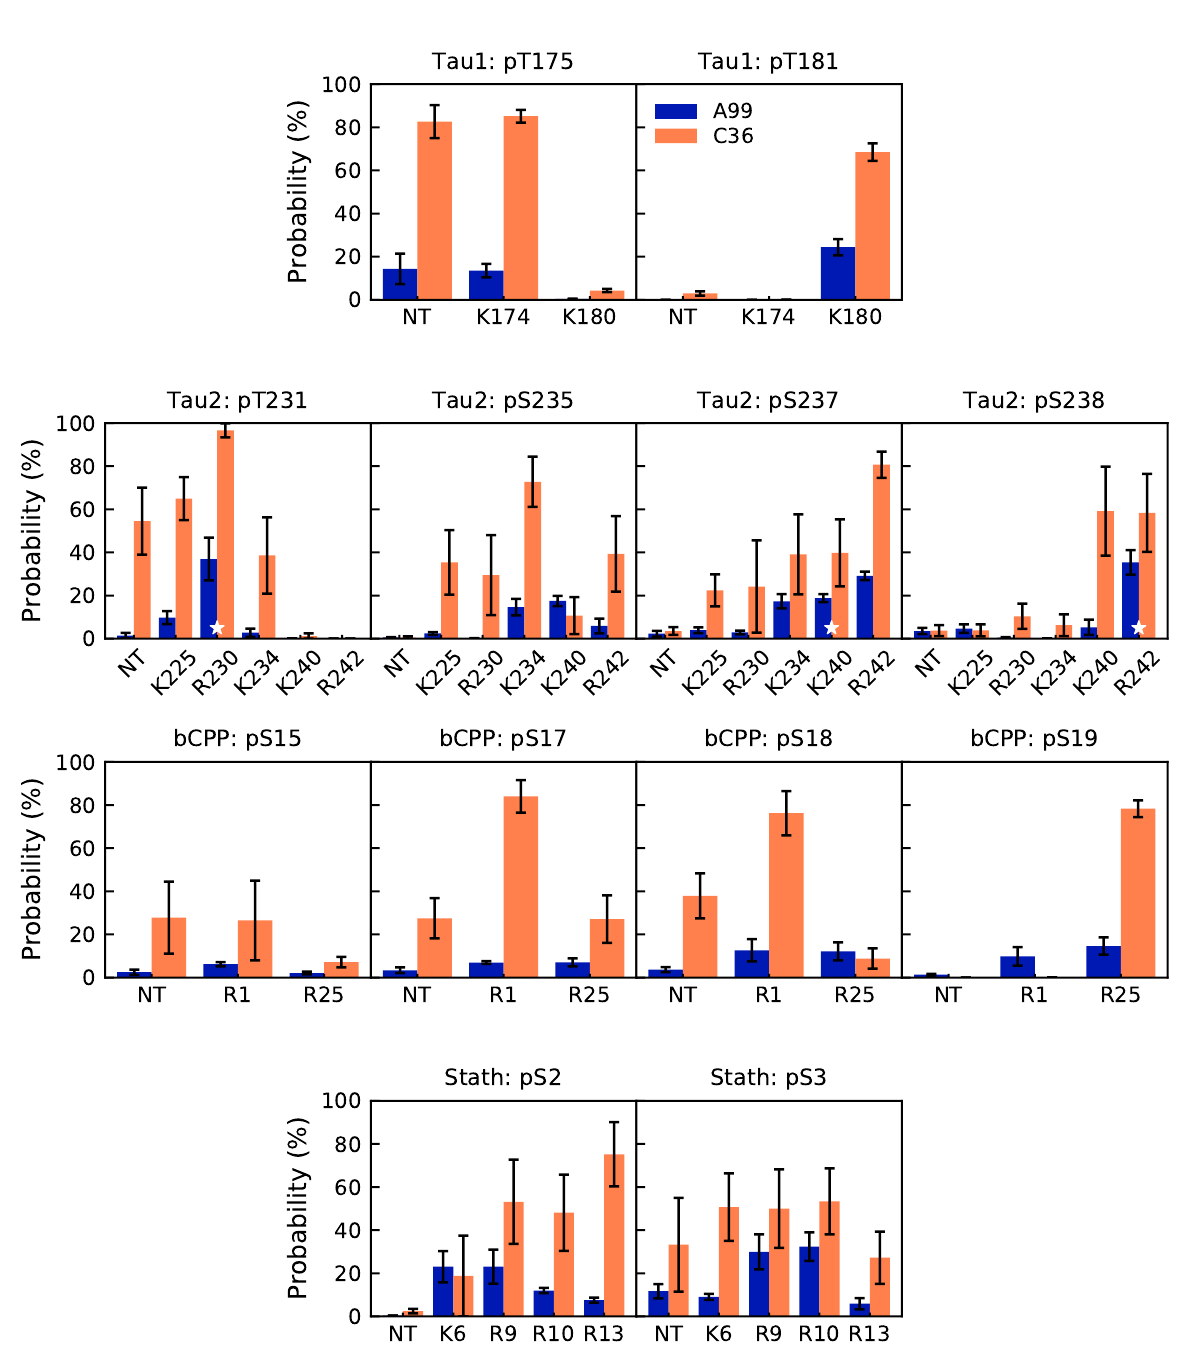
Figure 3. Probability of possible salt bridge interactions for the phosphorylated residues with the N-terminus (NT) and positively charged residues in Tau1 ( first row ), Tau2 ( second row ), bCPP ( third row ), and Stath ( last row ). For Tau2, experimentally established salt bridges [12] are marked with a white star. Error bars correspond to errors calculated by block